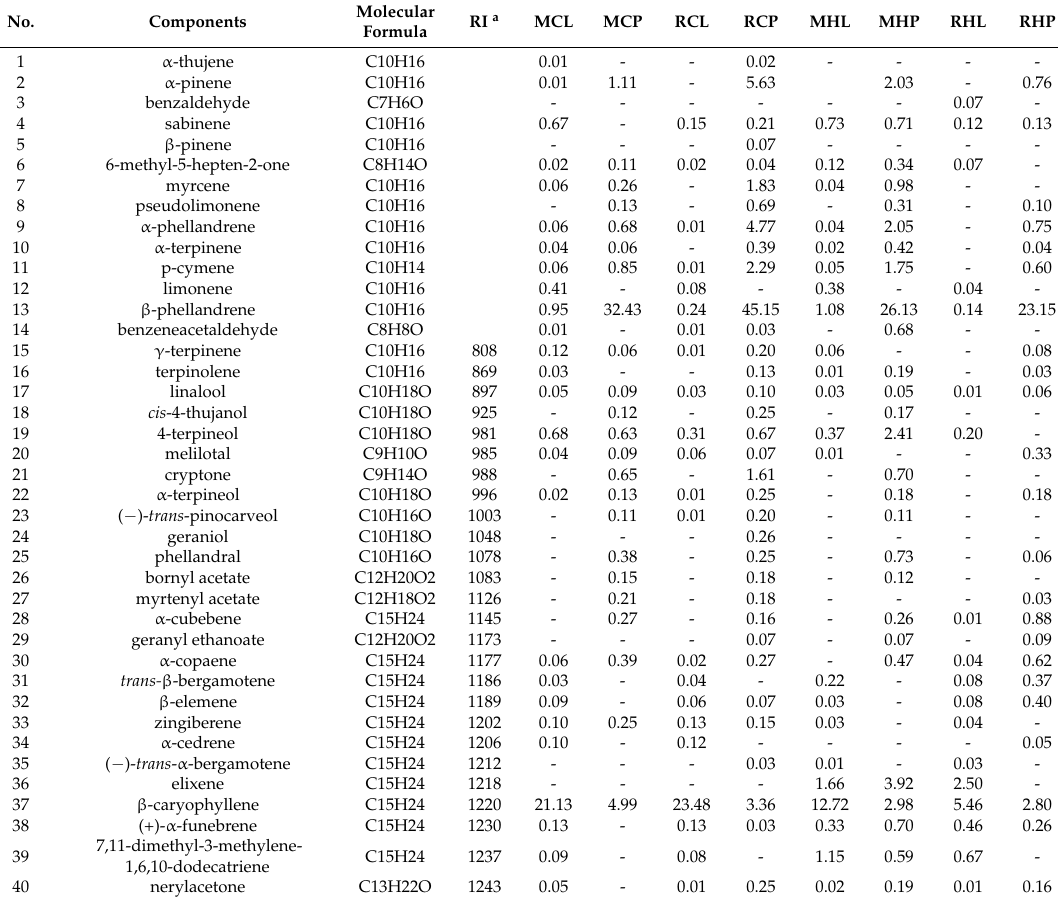
Figure 1. GC-MS chromatograms of Clausena lansium EOs. Table 2. Chemical components and contents (%) of Clausena lansium EOs.